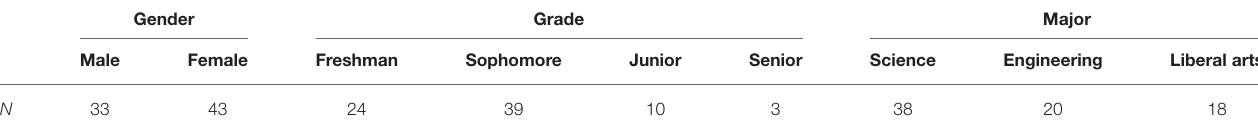
TABLE 1 | Basic information of participants. Gender Grade Male Female